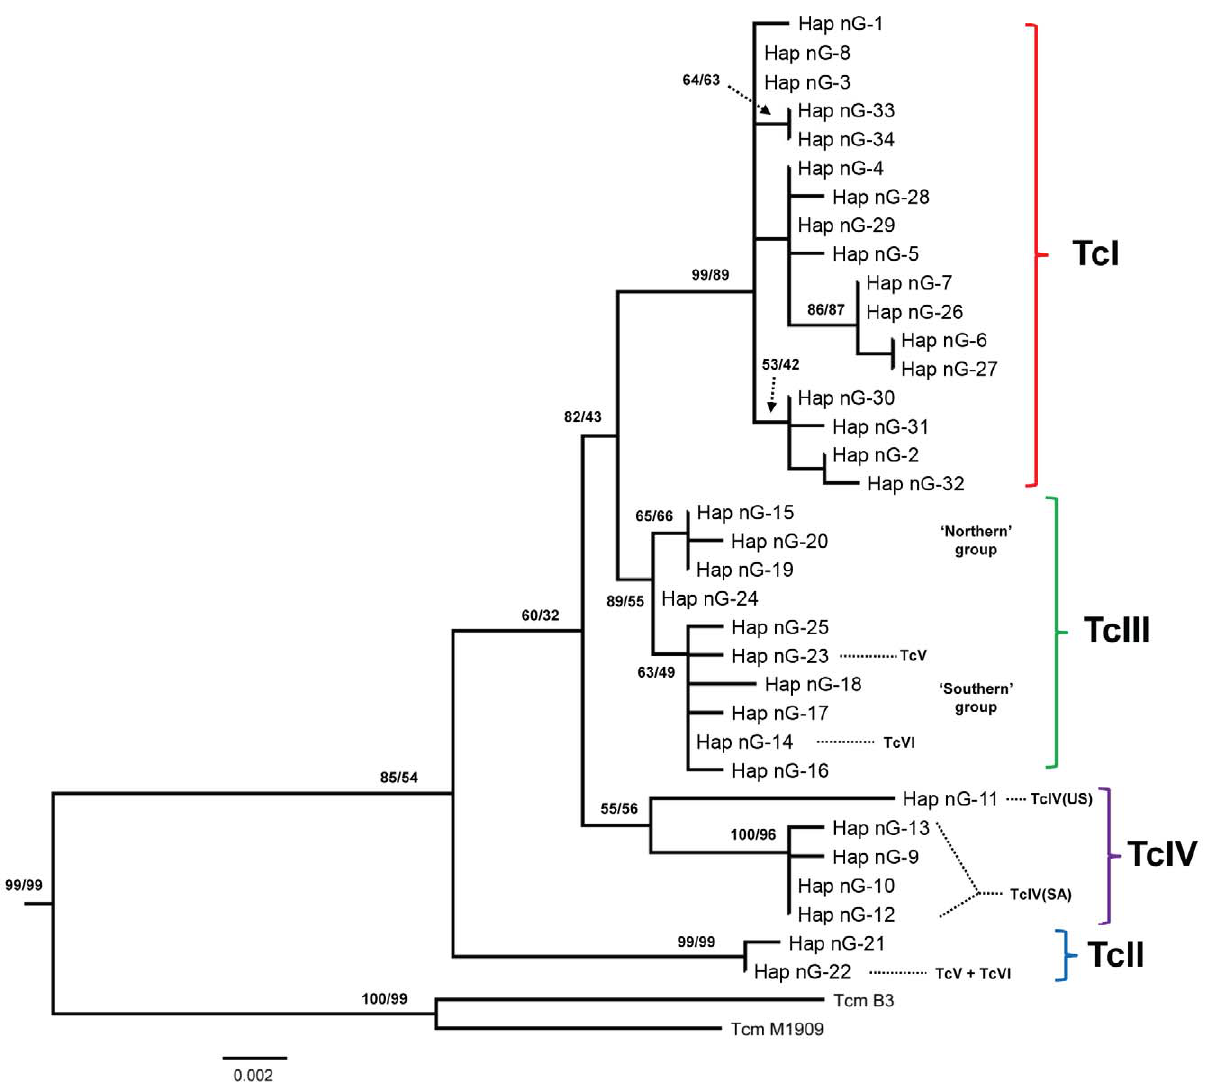
Figure 1. Maximum likelihood tree of GPI sequences (unique haplotypes). Four major clades are indicated according to corresponding T. cruzi lineage; TcV and TcVI haplotypes are within the parental TcII and TcIII clades from which they are derived. Where clear geographic associations were evident these are indicated: US (samples from USA); SA (samples from South America); ‘Northern’ and ‘Southern’ groups within TcIII are as defined previously [36]. Branches separating T. cruzi from T. rangeli and T. brucei (outgroup) are not shown. Bootstrap support values for branches (if . 50%) are shown and were calculated for the equivalent nodes of the bootstrap consensus NJ/MP trees (1000 replicates). Scale units are